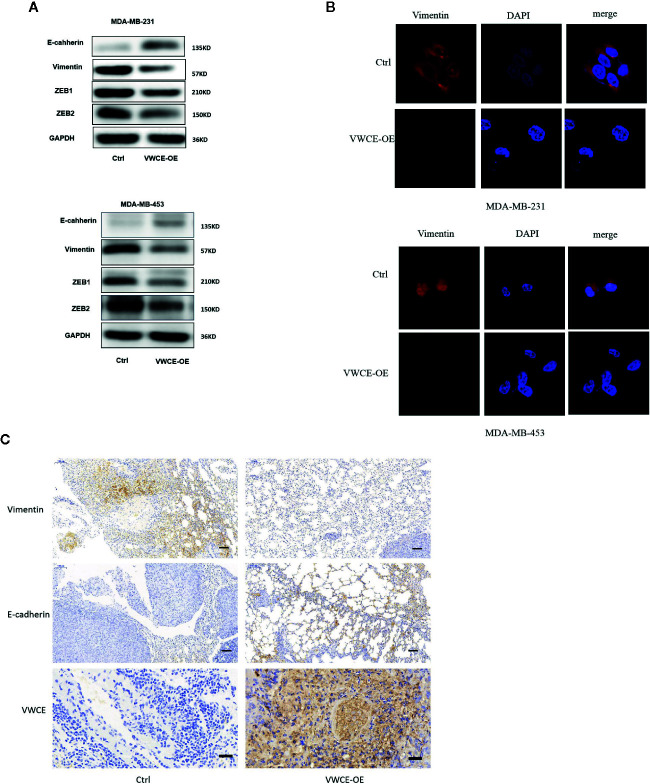
Von Willebrand factor C and EGF domain (VWCE) causes the reversal of EMT to MET in aggressive breast cancer cells. (A) EMT molecule markers were determined by Western blot. (B) Vimentin expression were evaluated by immunofluorescence in MDA-MB-231 and MDA-MB-453 cells treated by VWCE-overexpression or a control vector.(scale bar =100 μM) (C) Representative E-cadherin, vimentin, and VWCE expression in the lung metastases of a nude mouse model by immunohistochemistry (scale bar =100 μM).